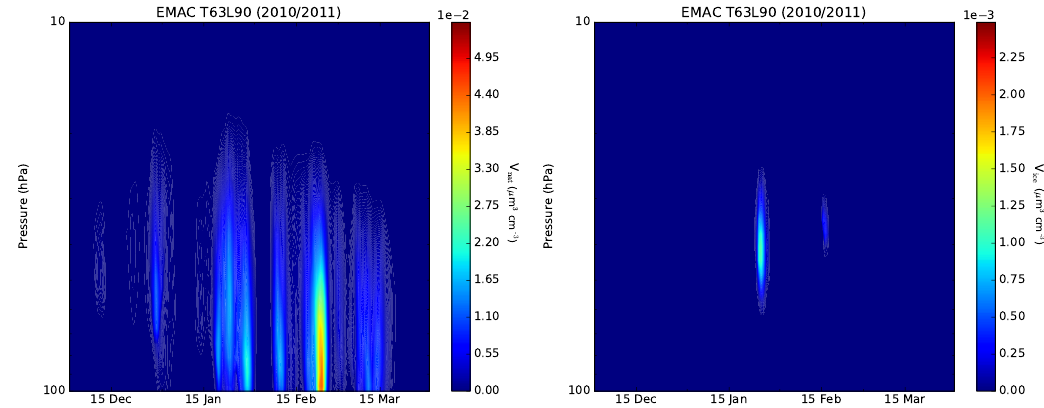
Figure 11. Volume density of solid particles ( V NAT and V ice ) in µm 3 cm − 3 as simulated with EMAC for the Arctic winter 2010/2011.